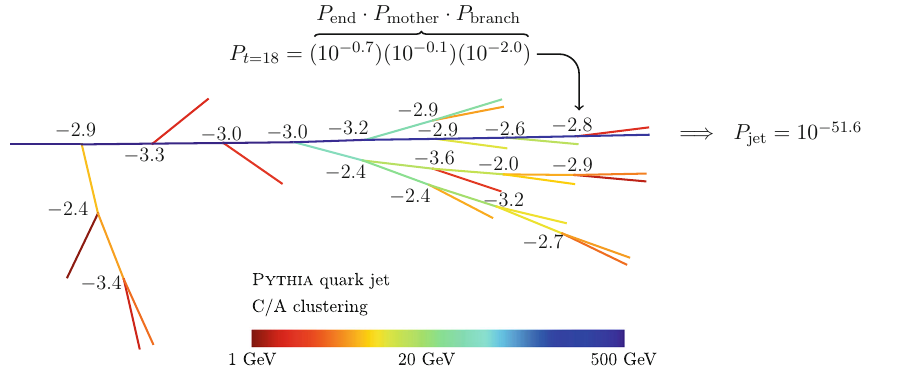
Fig. 11 Junipr -computed probability asigned to example Pythia jet and sequentially decomposed along its C/A clustering tree. Nodes are labeled with log 10 P t , where P t = P end · P mother · P branch includes the product of all three components of the probability at step t , as shown